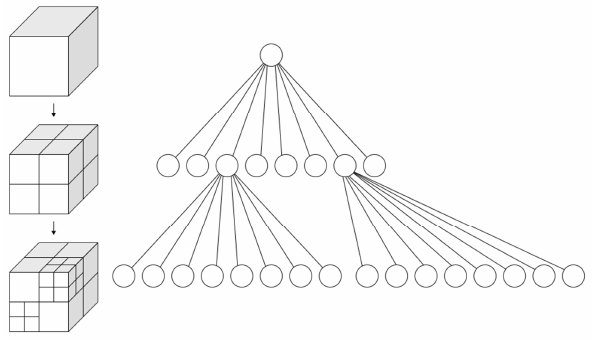
Fig. 1: Octree data structure for spatial indexing. The space is subsequently partitioned into eight equal sized sub-cubes. At the final nodes, the data is stored – enabling fast neighbourhood queries by top- down tree traversal. Image source: